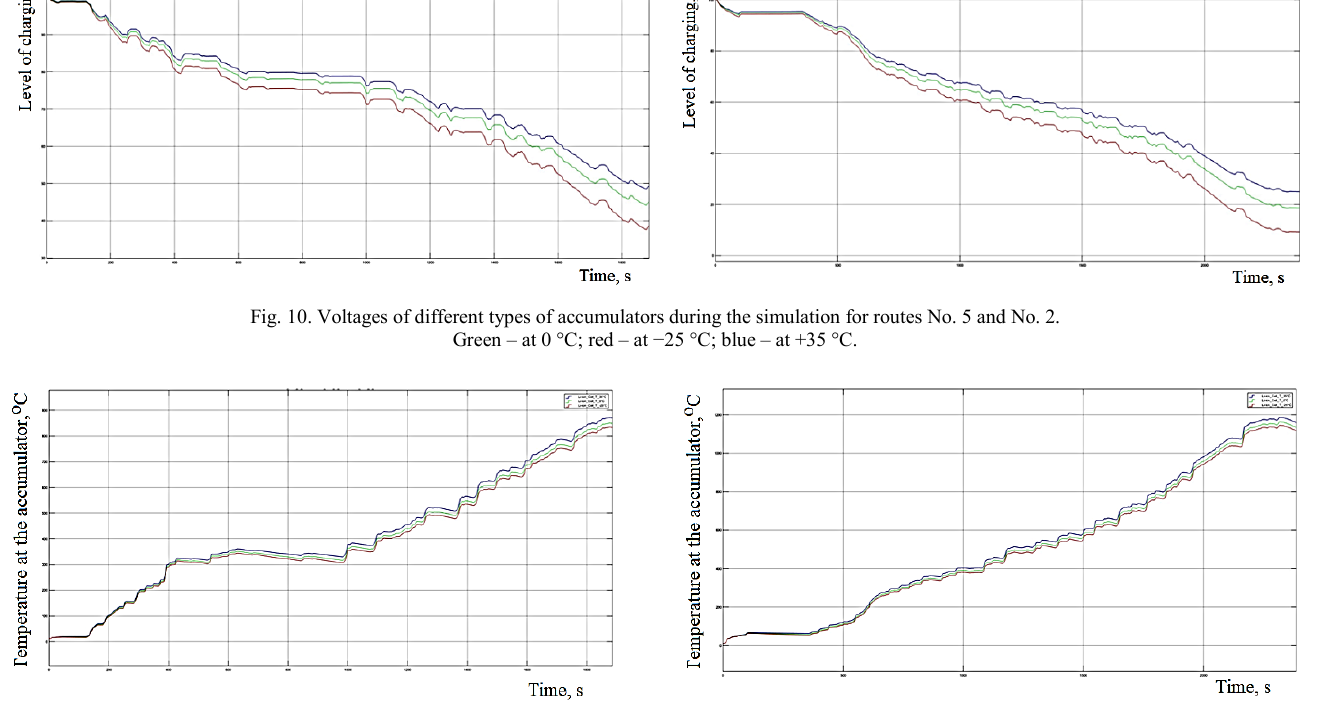
Fig. 11. Temperature of the accumulators for routes No. 5 and No. 2. Green – at 0 °C; red – at − 25 °C; blue – at +35